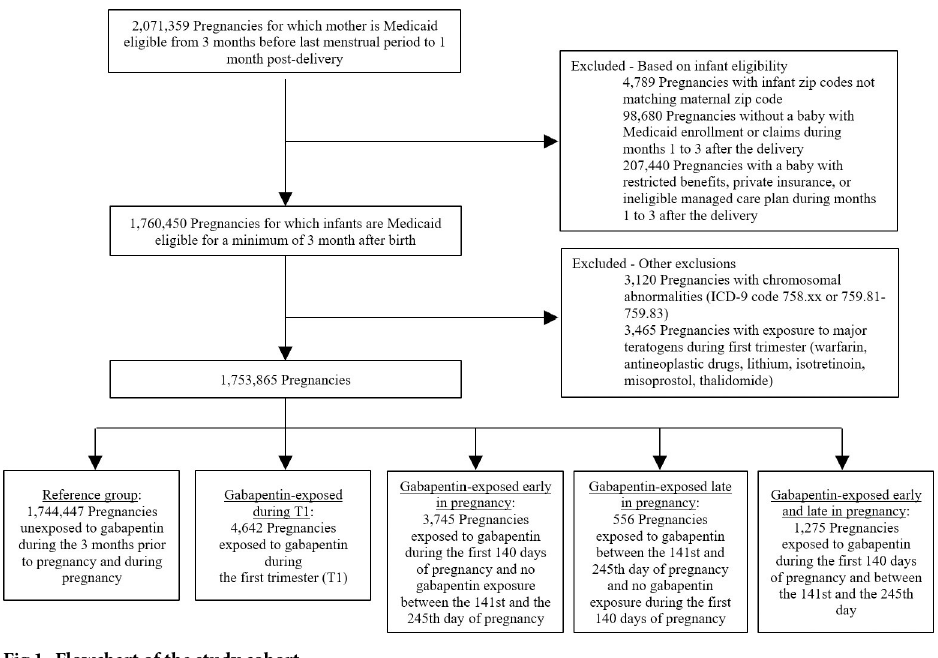
Fig 1. Flowchart of the study